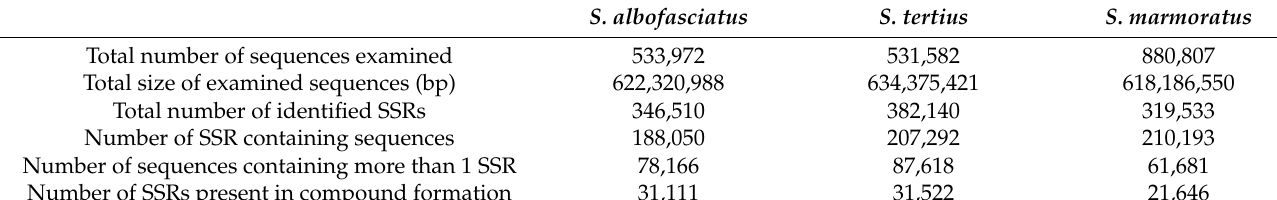
Table 4. Microsatellite motif types detected in this study.